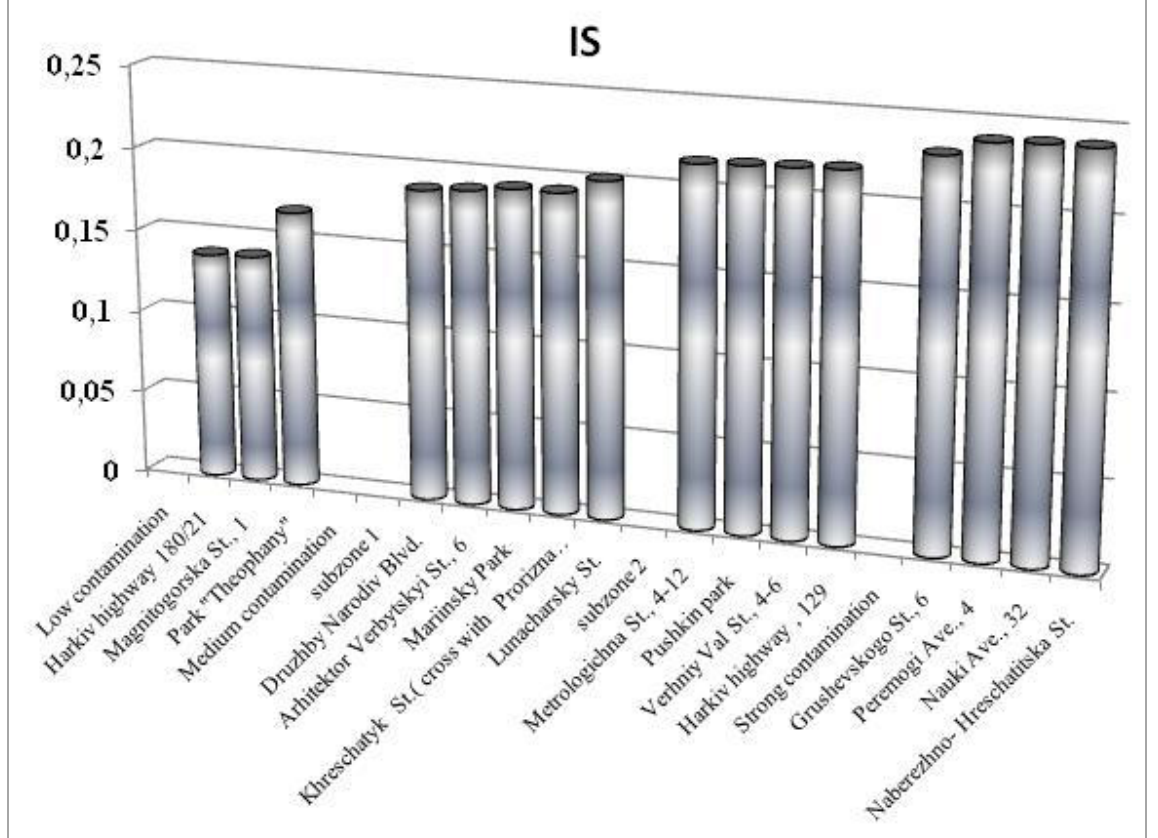
Fig. 2. Anthropogenic press zoning of Kyiv with a stress index (2014